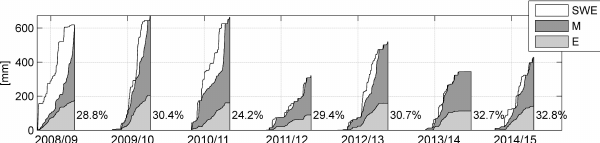
Figure 6. Cumulative snowfall together with the stacked cumula- tive snowmelt ( M ) and cumulative evaposublimation ( E ) (in mm) for each snow season at the Refugio Poqueira site from the hydro- logical year 2008/2009 to 2014/2015. The white area between the snowfall and the stacked M and E represents the instant snow water equivalent (SWE) during the year. The percentage at the end of ev- ery season indicates the ratio of annual evaposublimation compared to total